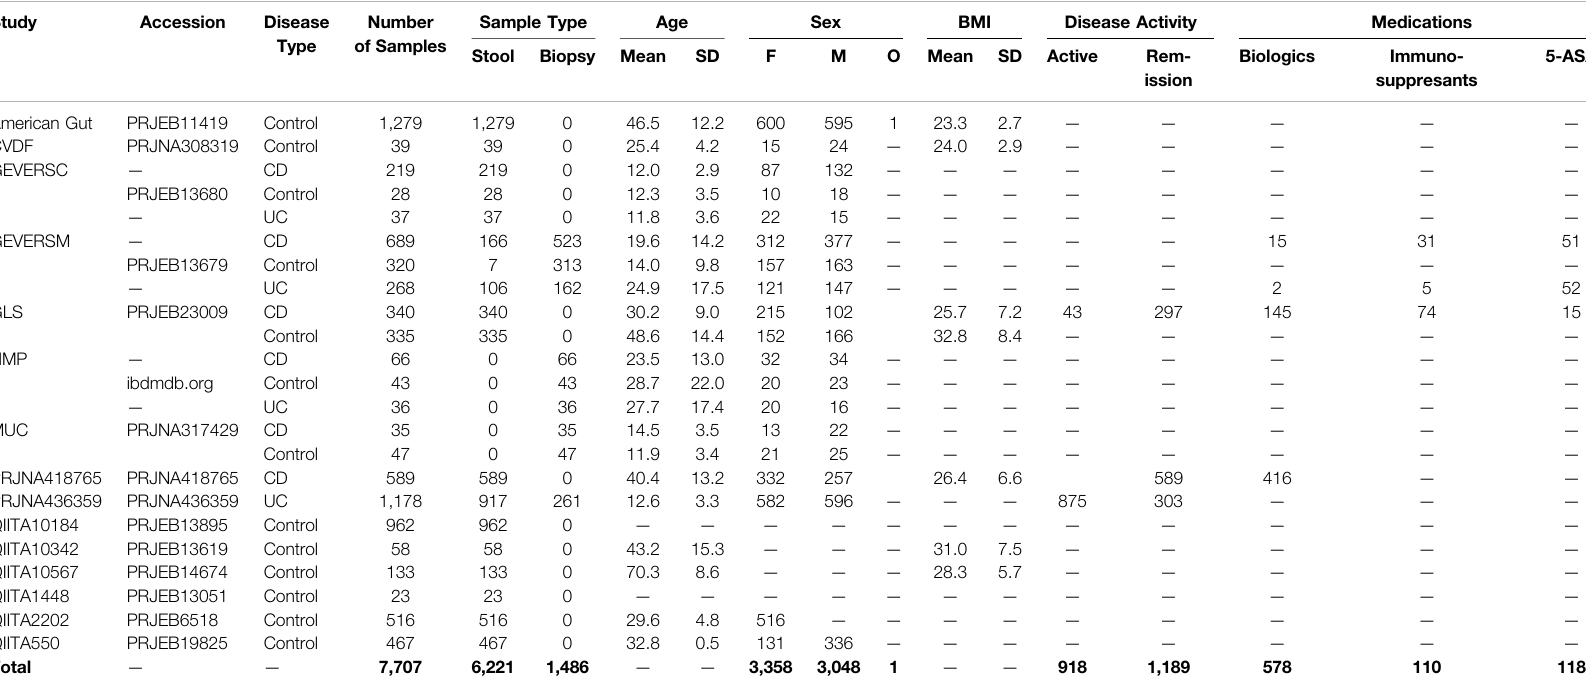
Bold values indicate the sum of the corresponding